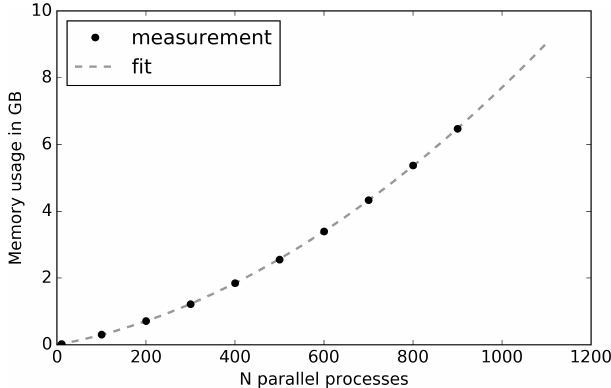
Figure 5. Memory usage of pySNMPdaq for different num- bers of parallel processes, i.e., simultaneous SNMP requests. The Processes alone contribute linearly, while their interprocess communication via Events contributes quadratically. A least square fit of the memory usage mem GB in gigabytes yields mem GB = 2 . 5 × 10 − 3 N processes + 5 . 2 × 10 − 6 N 2 processes